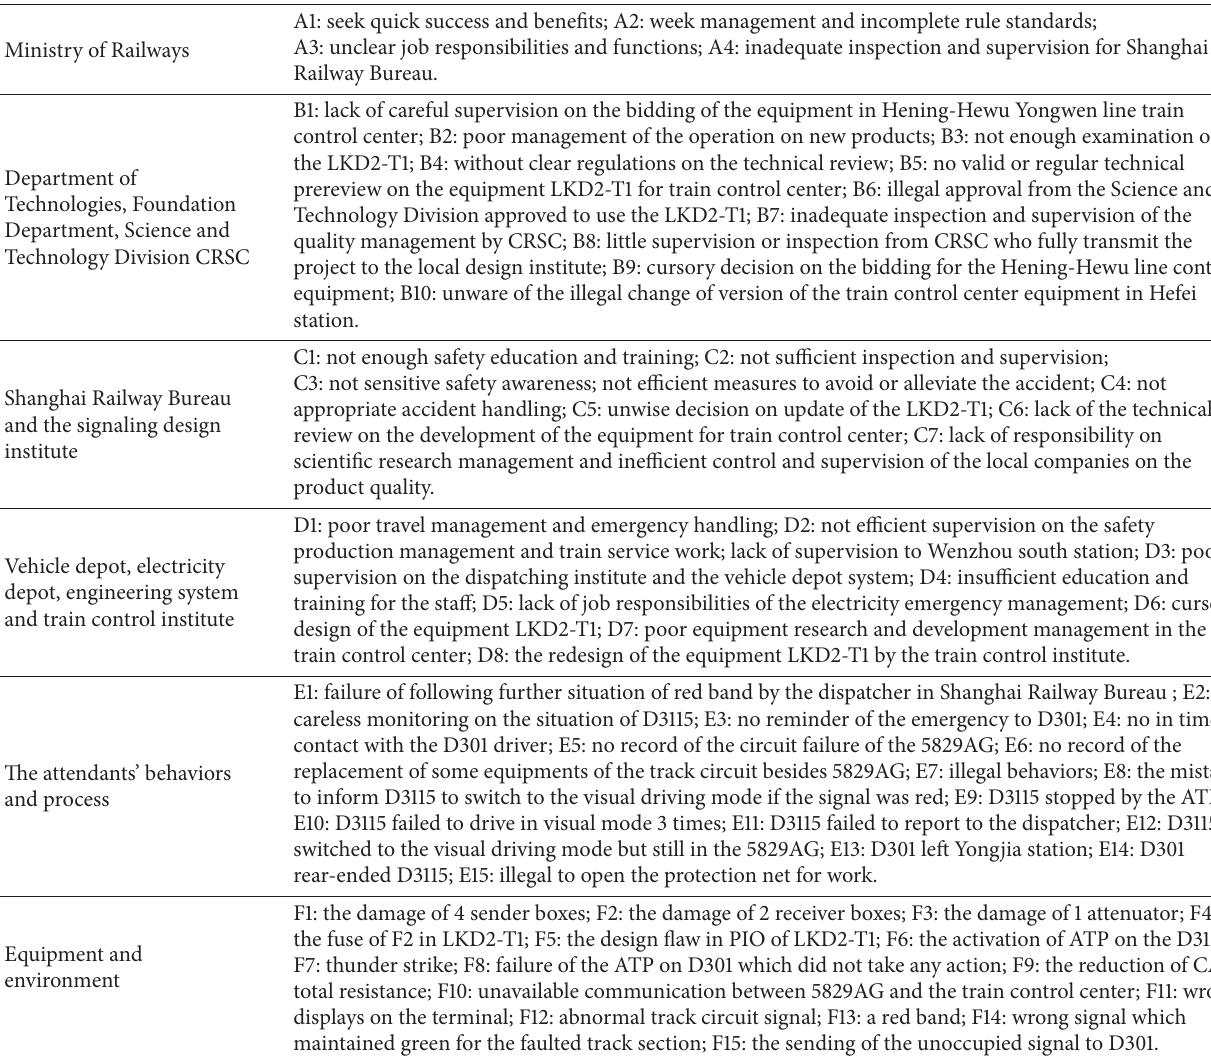
Table 1: Causation factors of the 7.23 China Yongwen railway accident